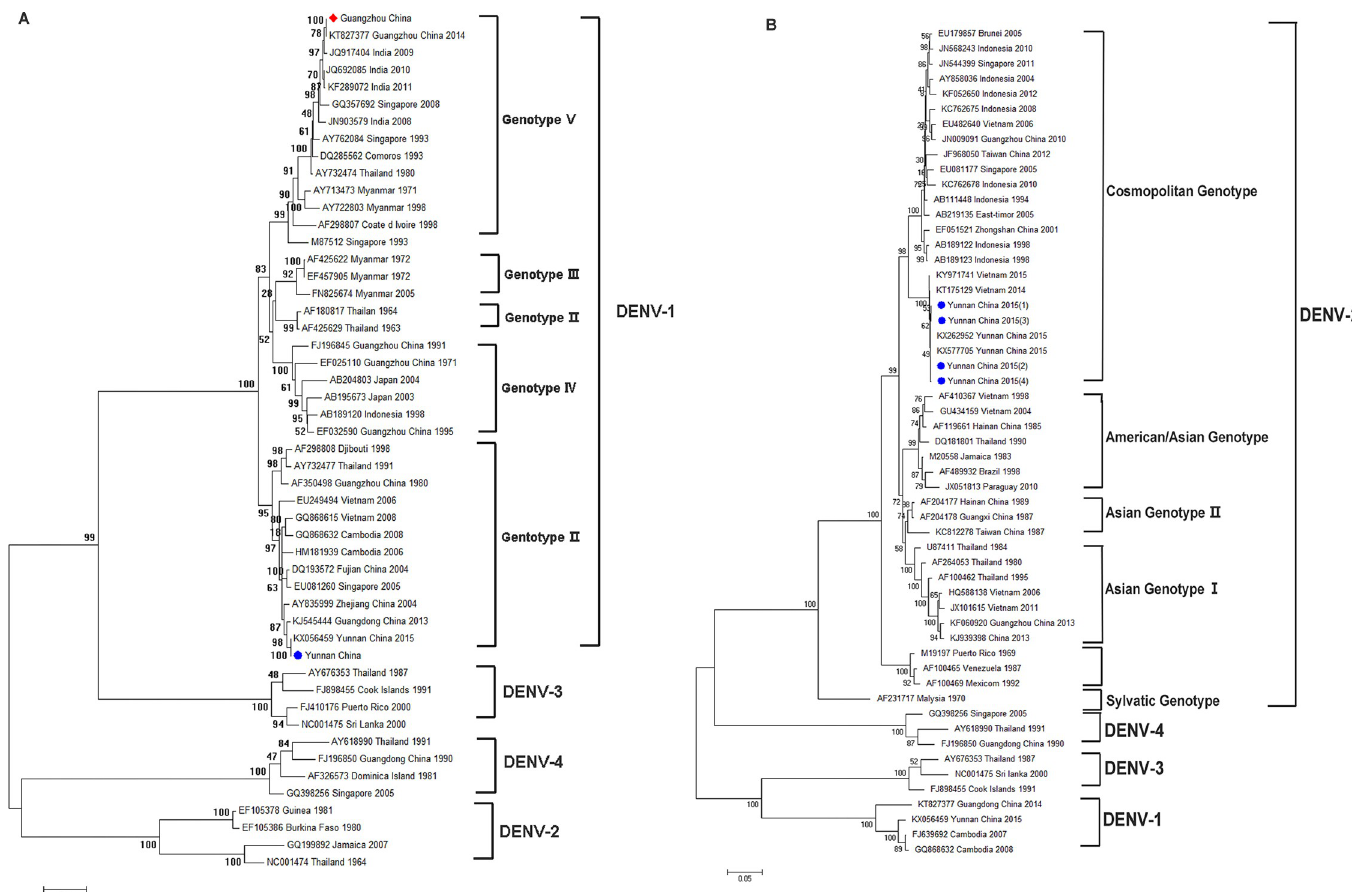
Fig 7. DENV phylogenetic trees. (A) The DENV-1 tree was constructed using the whole nucleotide envelope protein gene sequences from DENV-1 and shows the relationships of 50 strains from different sources including 10 DENV-1 strains isolated in China. (B) The DENV-2 tree was constructed using the whole nucleotide envelope protein gene sequences from DENV-2 and shows the relationships of 55 strains from different sources including 12 DENV-2 strains isolated in China. The sequences of this study were indicated as red diamonds (Guangzhou) and blue circles (Xishuangbanna).